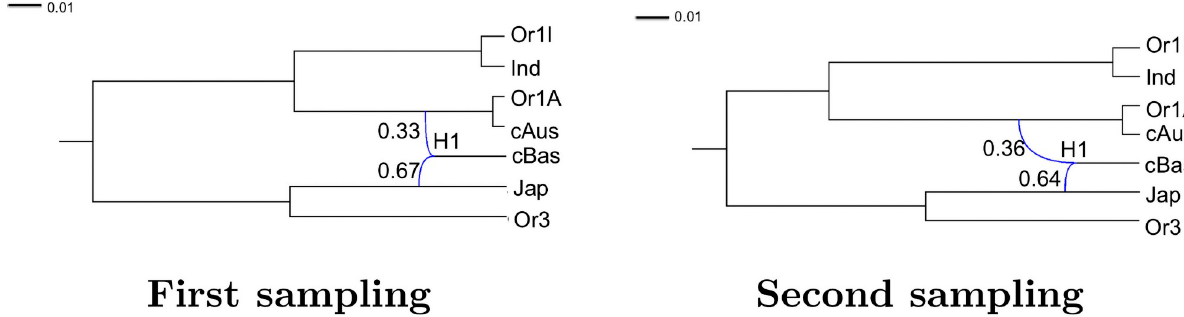
Fig 15. The two networks obtained for data set 1 with only one variety per subpopulation. Each network corresponds to the posterior mean of the distribution sampled by S NAPP N ET . Inheritance probabilities are reported above reticulation edges and branch lengths are given in units of expected number of mutations per site (see the scale at the top